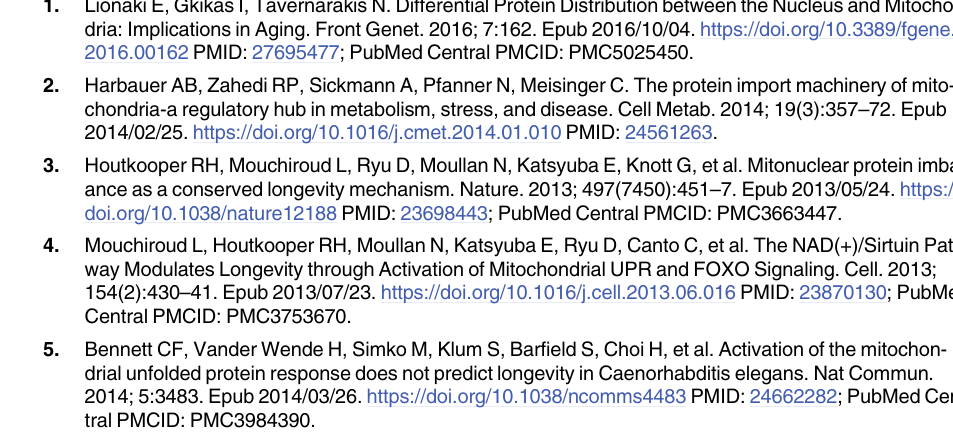
S1 Table. Summary of lifespan and survival data with statistics. S2 Table. Summary of RNA sequencing analysis comparing wild-type, mrpl-2(osa3) , and metr-1(ok521) animals fed E . coli